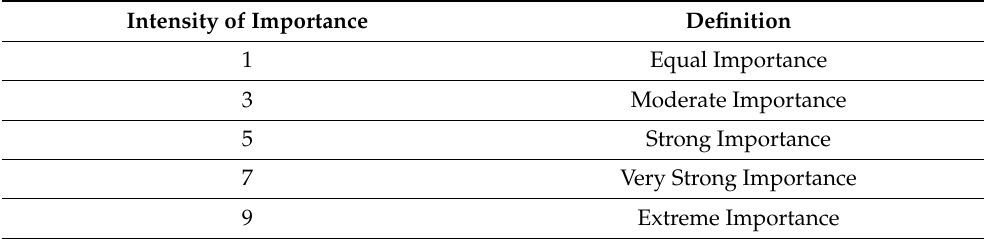
Table 2. Continuous rating scale for a pairwise comparison of Saaty’s method